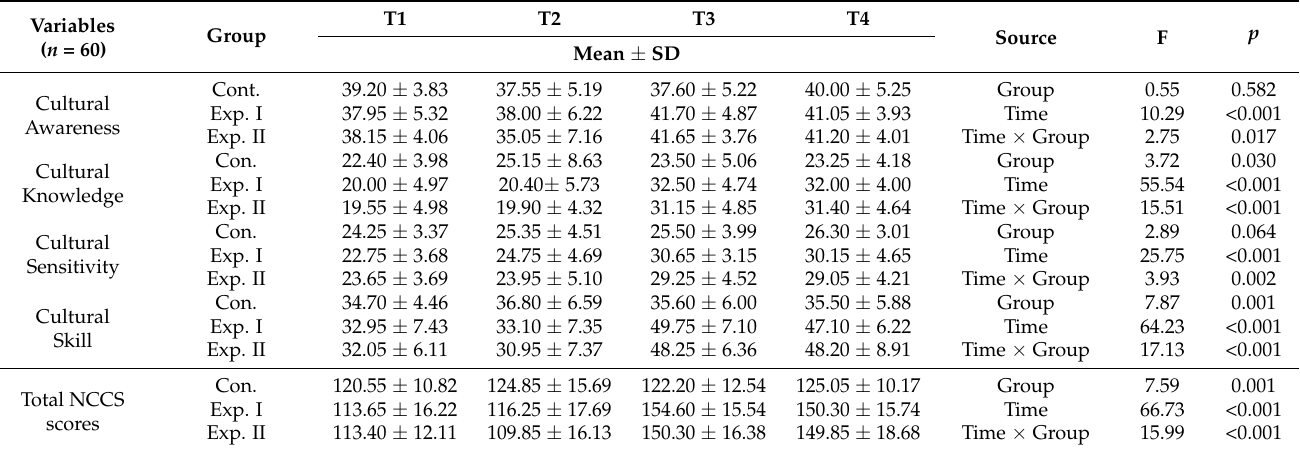
Table 4. The comparison of NCCS score and subscales among three groups (N =